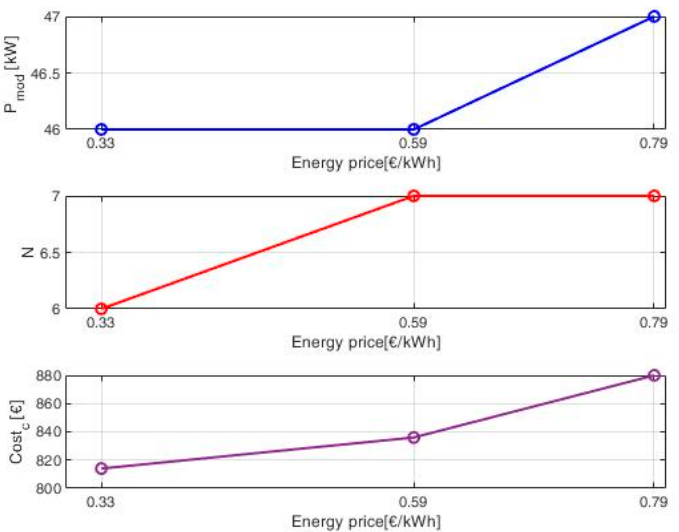
Figure 12. Optimization parameters variables for energy price variations.